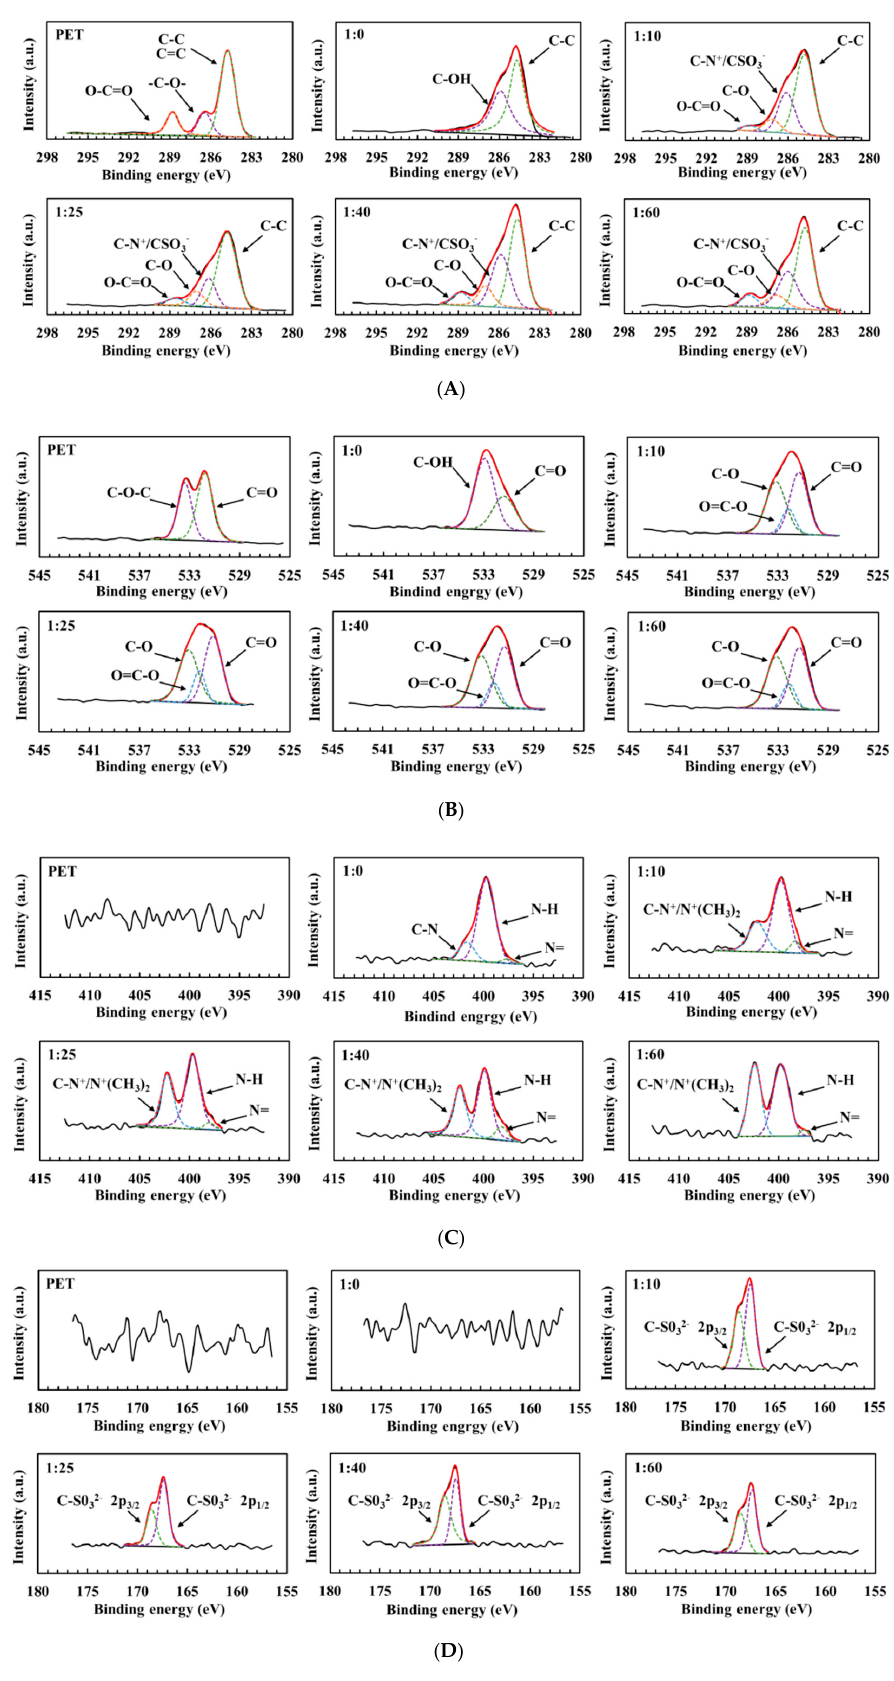
Figure 4. High-resolution spectra of C1s ( A ), O1s ( B ), N1s ( C ), and S2p ( D ) of the PDA/SBMA coatings.